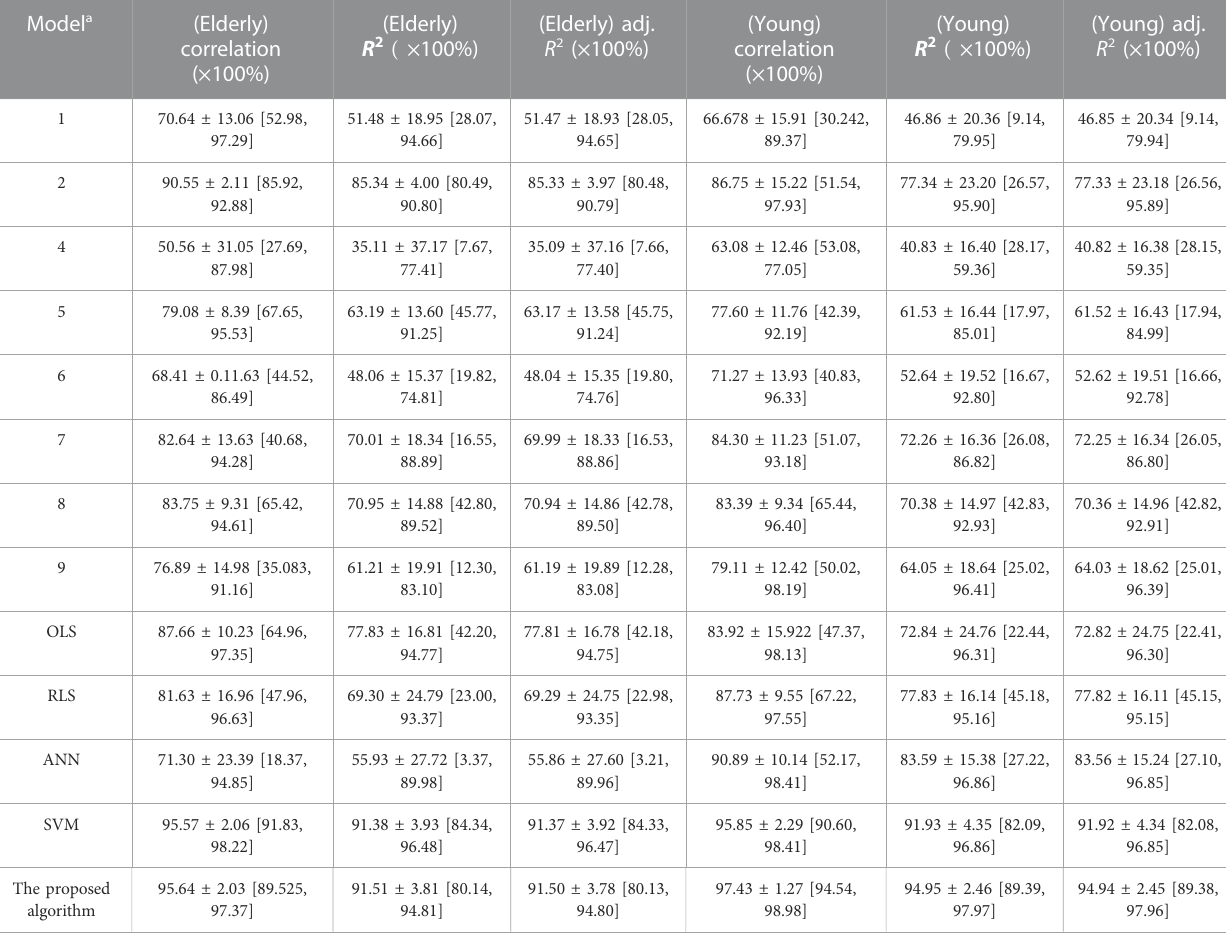
TABLE 2 The results of different models on the test set of lower limb dataset in MEAN ± SD [minimum, maximum] (50% hold-out validation). Model